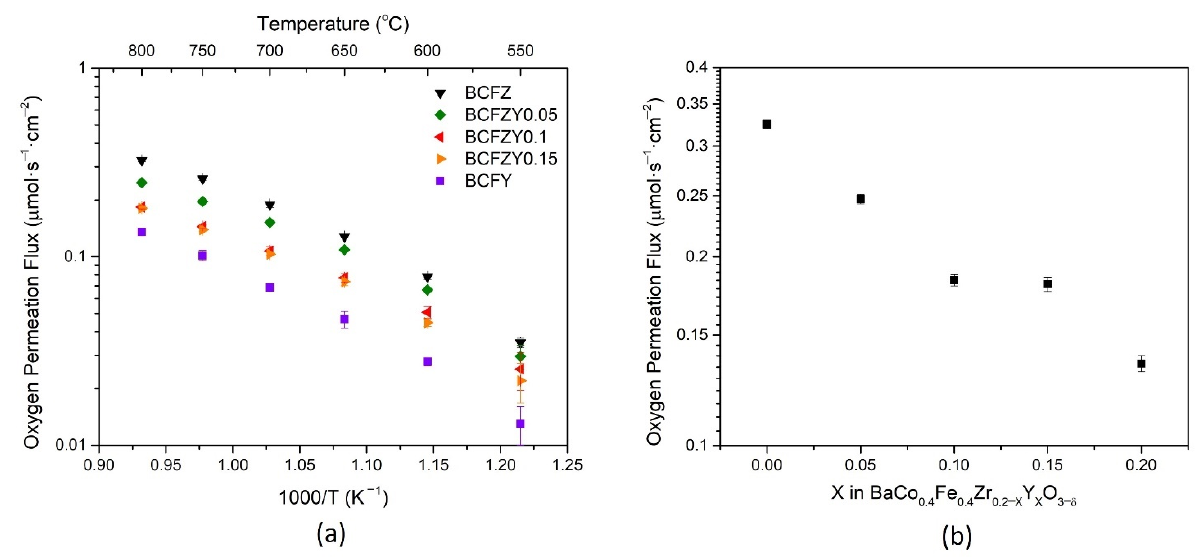
Figure 3. Oxygen permeation flux normalized for 1 mm BCFZY X pellets as a function of ( a ) temperature, and ( b ) Y stoichiometry at 800 °C.